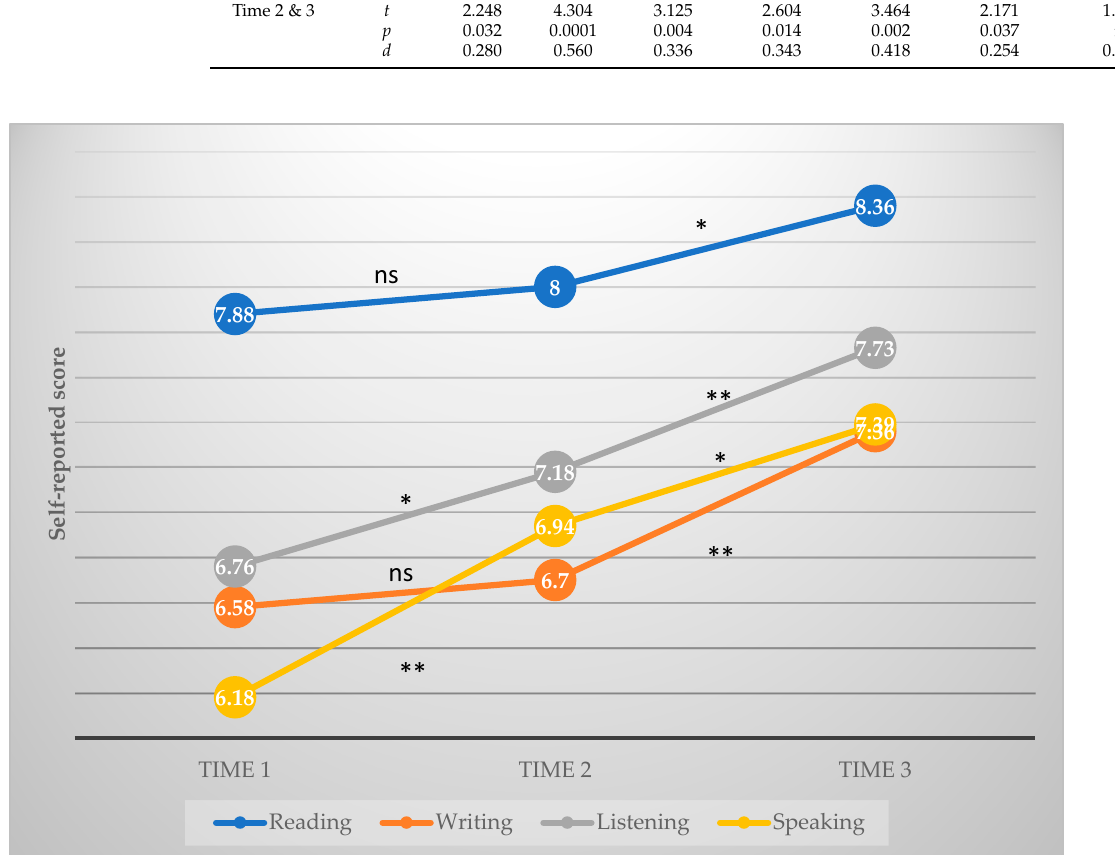
Figure 5. Mean scores for self-reported proficiency in the four skills at Times 1, 2, and 3 ( ns non-significant, * p < 0.05, ** p < .0.01).